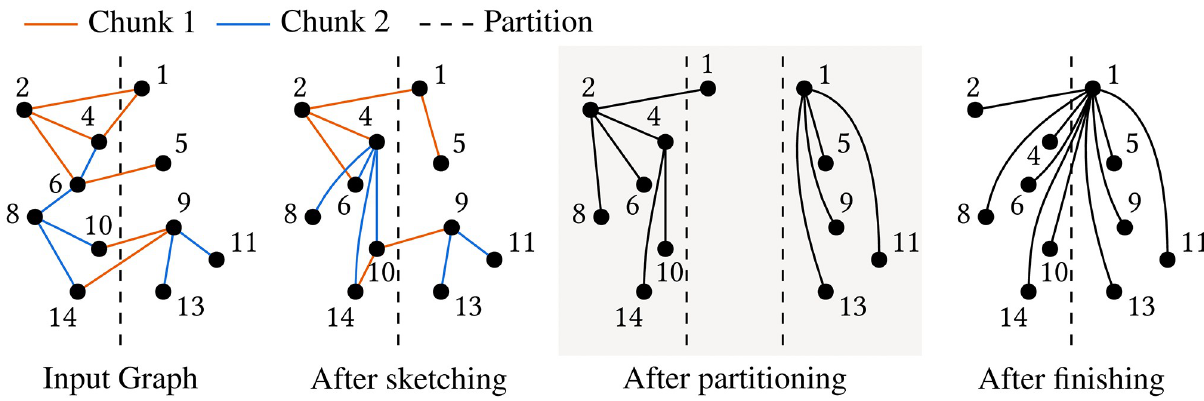
Fig 1. An example showing the input and output for each step of